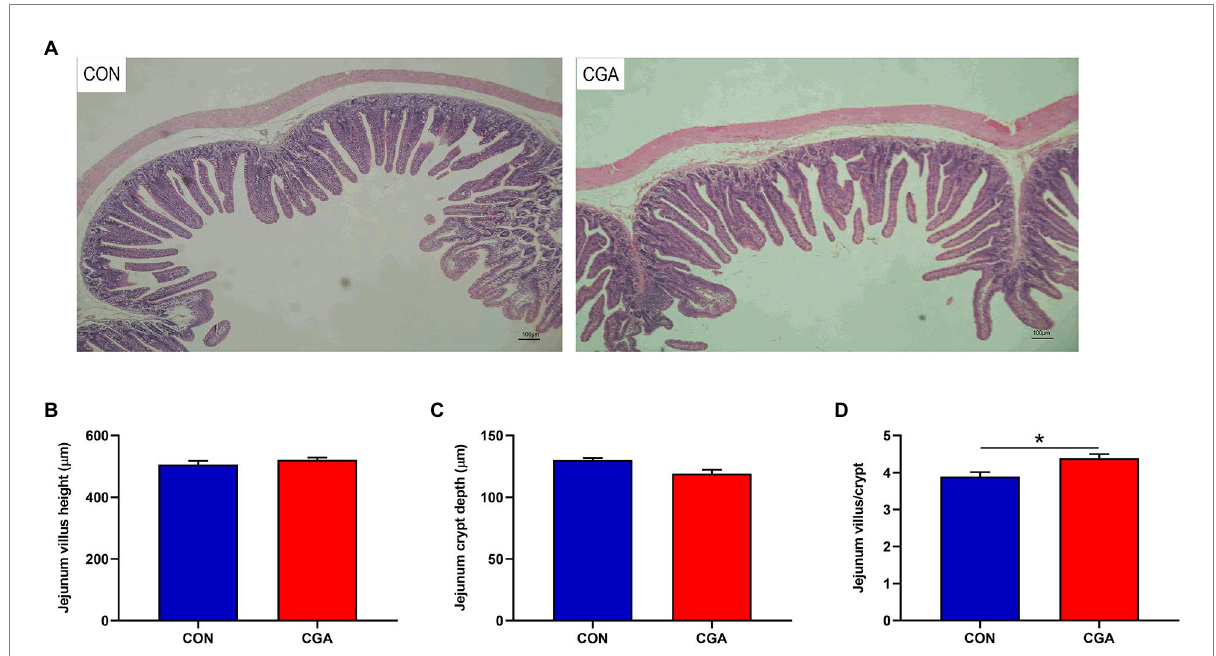
FIGURE 1 Effects of CGA on intestinal morphology in the jejunum of weaned rabbits. (A) Hematoxylin and eosin photomicrographs obtained at 100 × magnification; (B) Villus height; (C) Crypt depth; (D) Villus height/crypt depth ratio. CON, rabbits fed a basal diet; CGA, rabbits fed the basal diet supplemented with 800 mg/kg chlorogenic acid. Results are presented as mean and SEM ( n = 8). Significant difference was recorded by 0.01 < p <